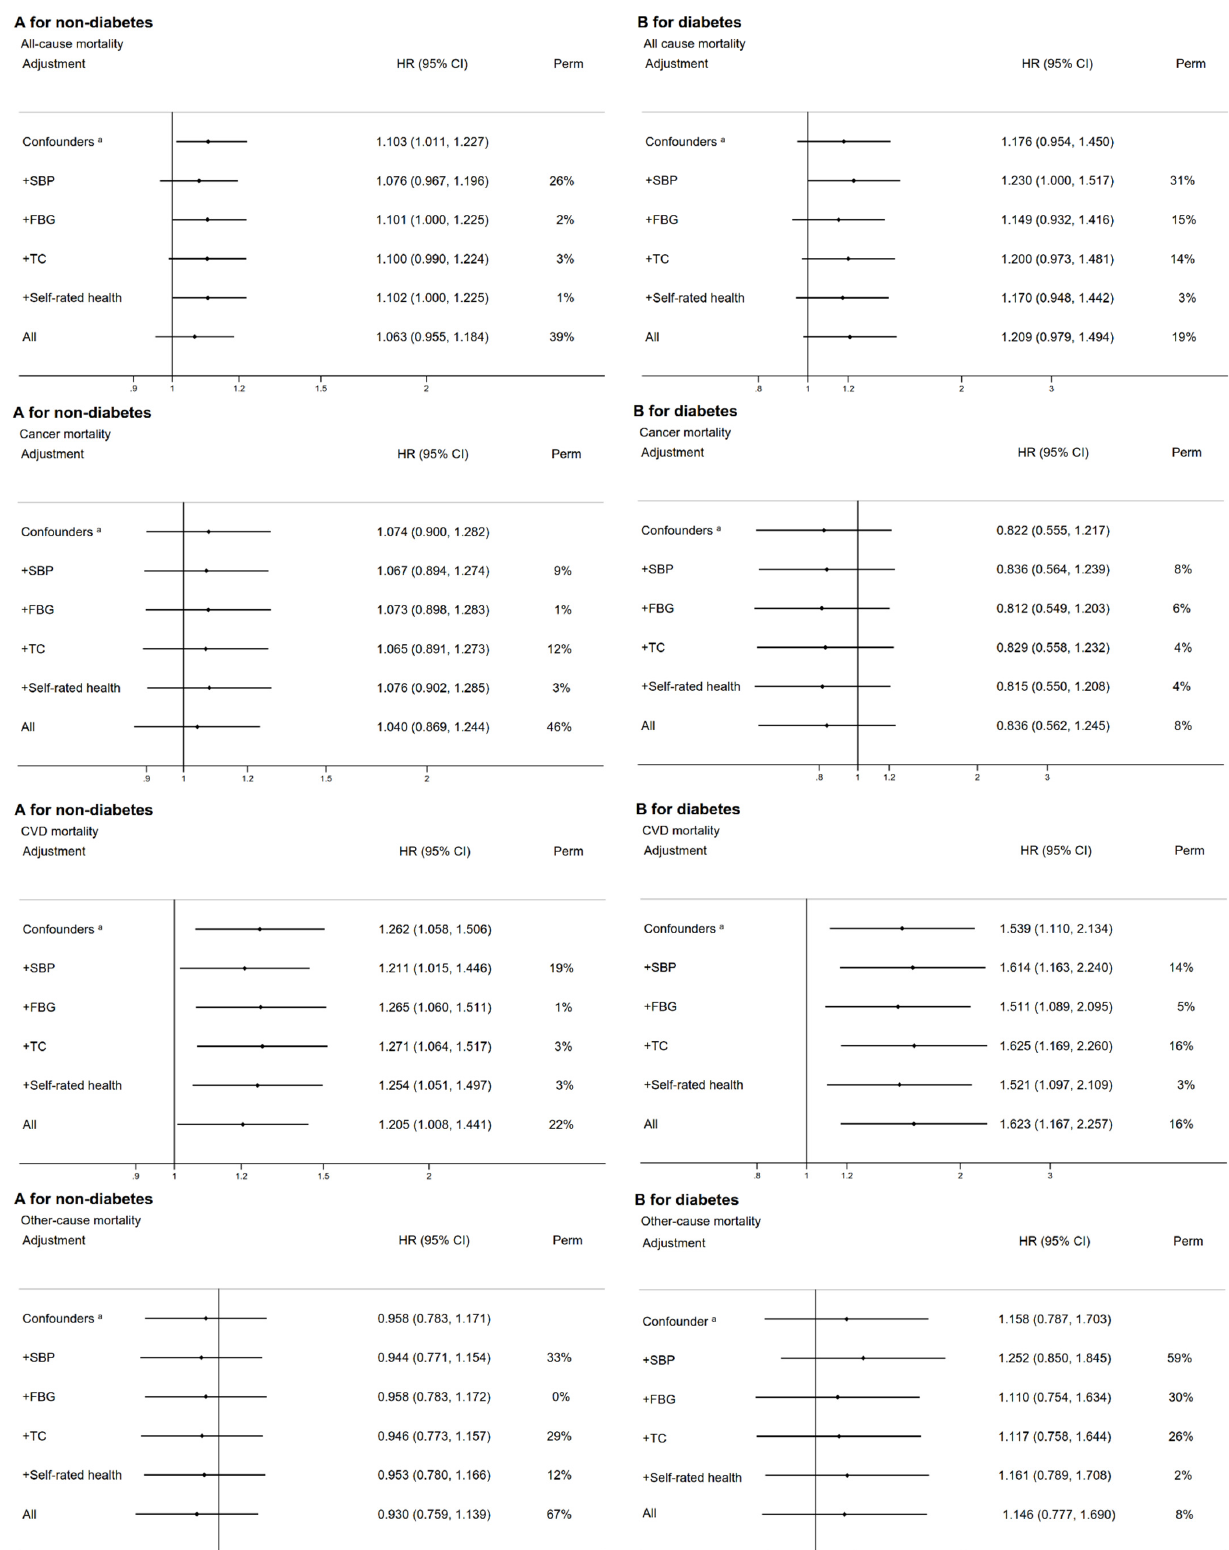
Figure 1. The associations between the LCD score (Q4 versus Q1) and all-cause mortality, and the proportions of the associations attributable to systolic blood pressure, fasting plasma-glucose, total cholesterol, and self-rated health in all-participants ( A : vegetable-based LCD score, B : meat-based LCD score).